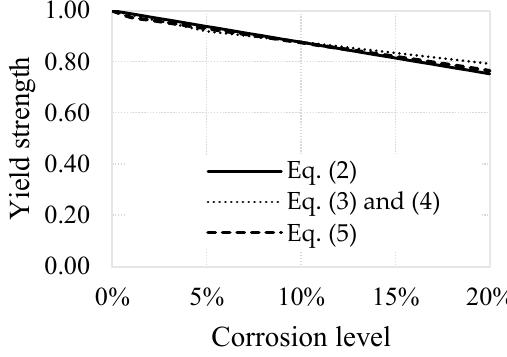
in the transverse reinforcement, the corrosion reduced the confining ability, increased the crack widths, and changed the cracking pattern. Figure 4. Yielding strength of reinforcing rebar.